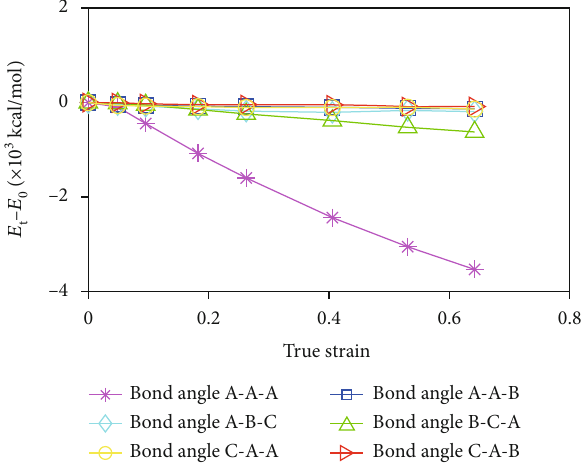
Figure 8: Evolution of total potential energy of di ff erent types of bond angles for a coarse-grained PU matrix containing 100 molecular chains for a strain rate of 2 × 10 11